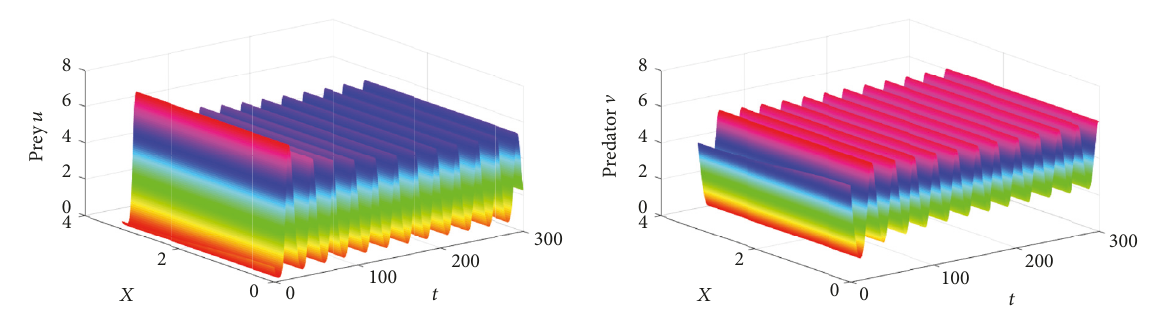
Figure 3: Hopf bifurcation occurs with parameters 𝑟 1 = 0.9, 𝛼 = 2/3, 𝛽 = 0.1, 𝑟 2 = 0.18, 𝐾 = 10; 𝜌 = 0.2